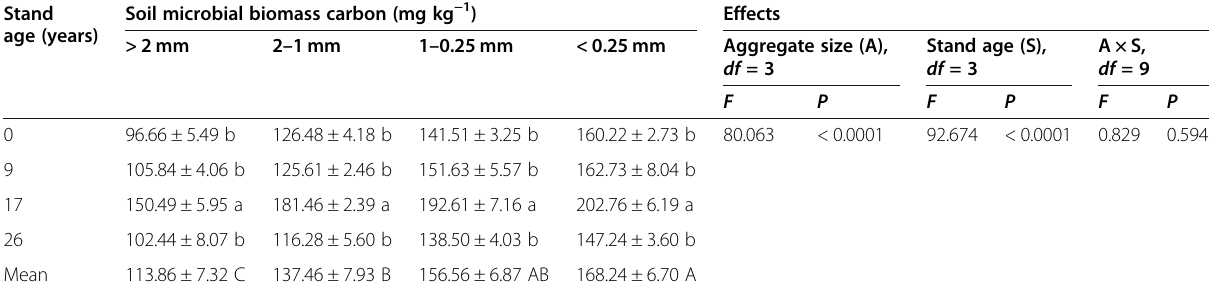
Table 6 Effects of aggregate sizes (> 2, 2 – 1, 1 – 0.25, and < 0.25 mm) and stand ages (0, 9, 17, and 26 years old) on the soil microbial biomass carbon in a chronosequence of Chinese fir plantations Stand age (years)